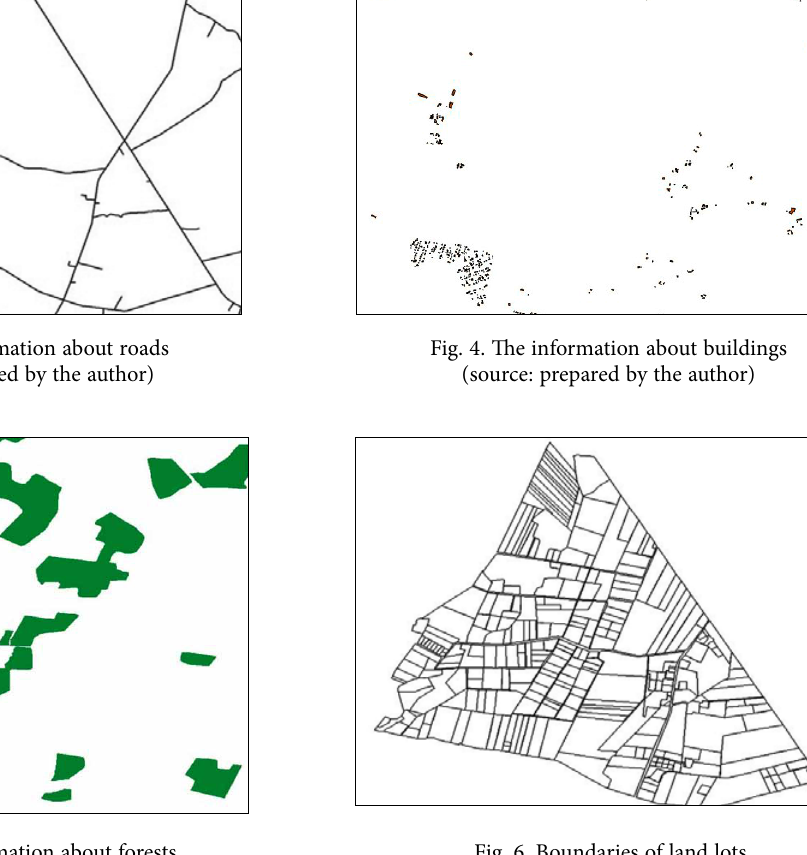
Fig. 5. The information about forests Fig. 6. Boundaries of land lots